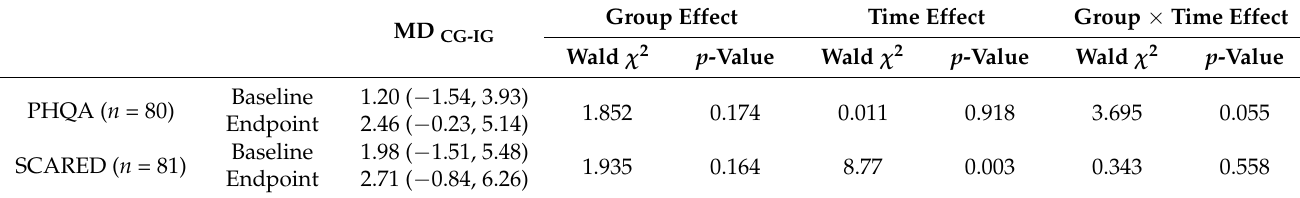
Table 3. Overall test and mean difference between intervention and control groups for the outcomes in GEE analysis. MD CG-IG